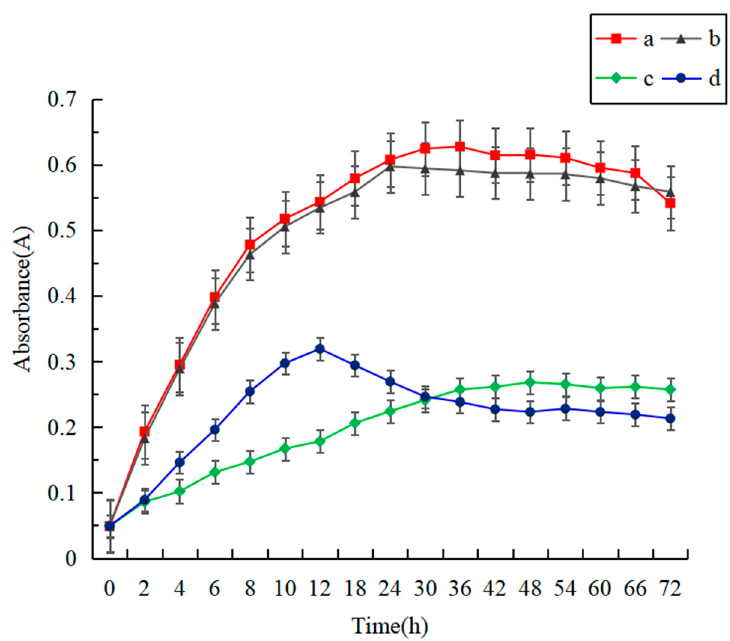
Figure 5. Verification of antibacterial activity of fiber membrane (a–d respectively represent zein, zein fiber membrane, free methyl ferulate, methyl ferulate/zein fiber membrane). Table 2. Verification of antioxidant activity of fiber